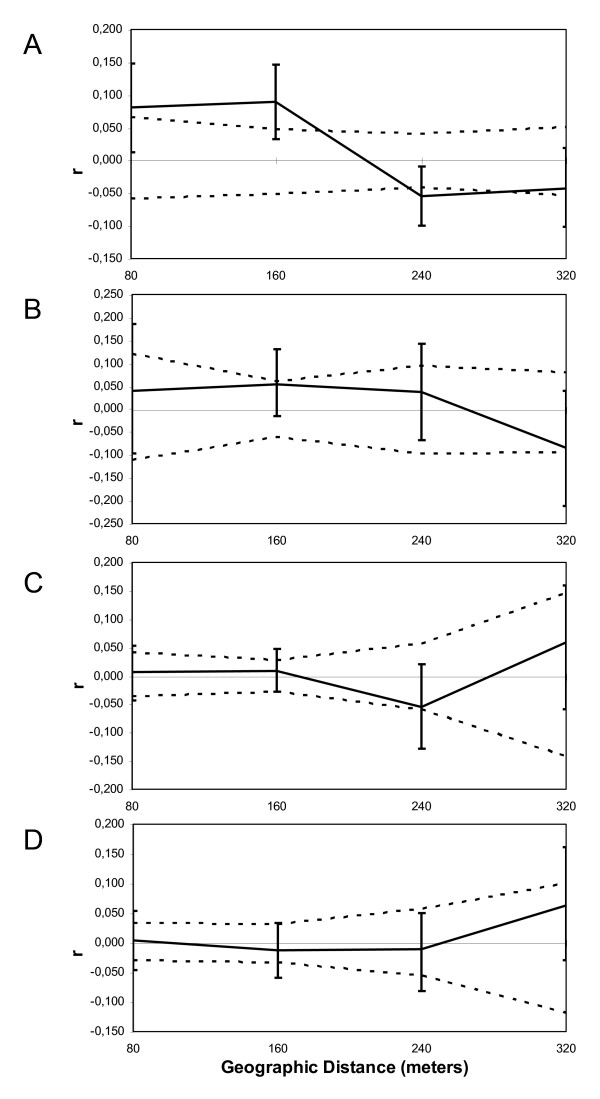
Spatial autocorrelation analyses. Spatial genetic structure autocorrelograms for females and males from the Western (A and B, respectively) and females and males from the Eastern sampling sites (C and D, respectively) showing the genetic correlation coefficient (r) as a function of geographical distance (only four distance classes of 80 meters each one are represented). The 95% confidence intervals for the autocorrelation coefficients (r) are also shown (broken line).